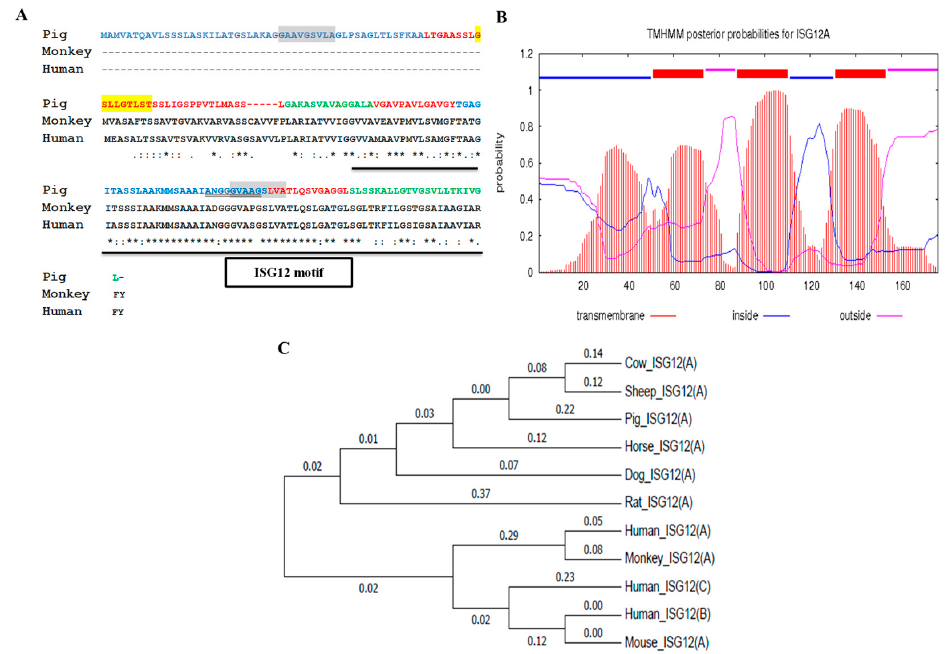
Figure 1. Sequence and phylogenetic analysis. ( A ) Interferon-stimulated gene 12a ( ISG12A ) homologues contain a conserved interferon-stimulated gene 12 (ISG12) motif (amino acid with underline), but porcine ISG12A has a unique amino acid sequence in its N terminal. Porcine ISG12A has four glycine zipper motifs (two GXXXGXXXA motifs with gray base color, one GXXXGXXXT motif with yellow base color and one AXXXGXXXG motif with double underline); “-”: without amino acid; “.”: weak similar amino acid; “:”: Strong similar amino acid; “*”: identical amino acid; ( B ) transmembrane helices of porcine ISG12A were predicted, probability >0.6. The transmembrane helices sequence was marked by red (Figure 1A); The inside sequence was marked by blue (Figure 1A); The outside sequence was marked by pink (Figure 1A); ( C ) phylogenetic tree showed the relationship between porcine ISG12A and homologues of nine other species.